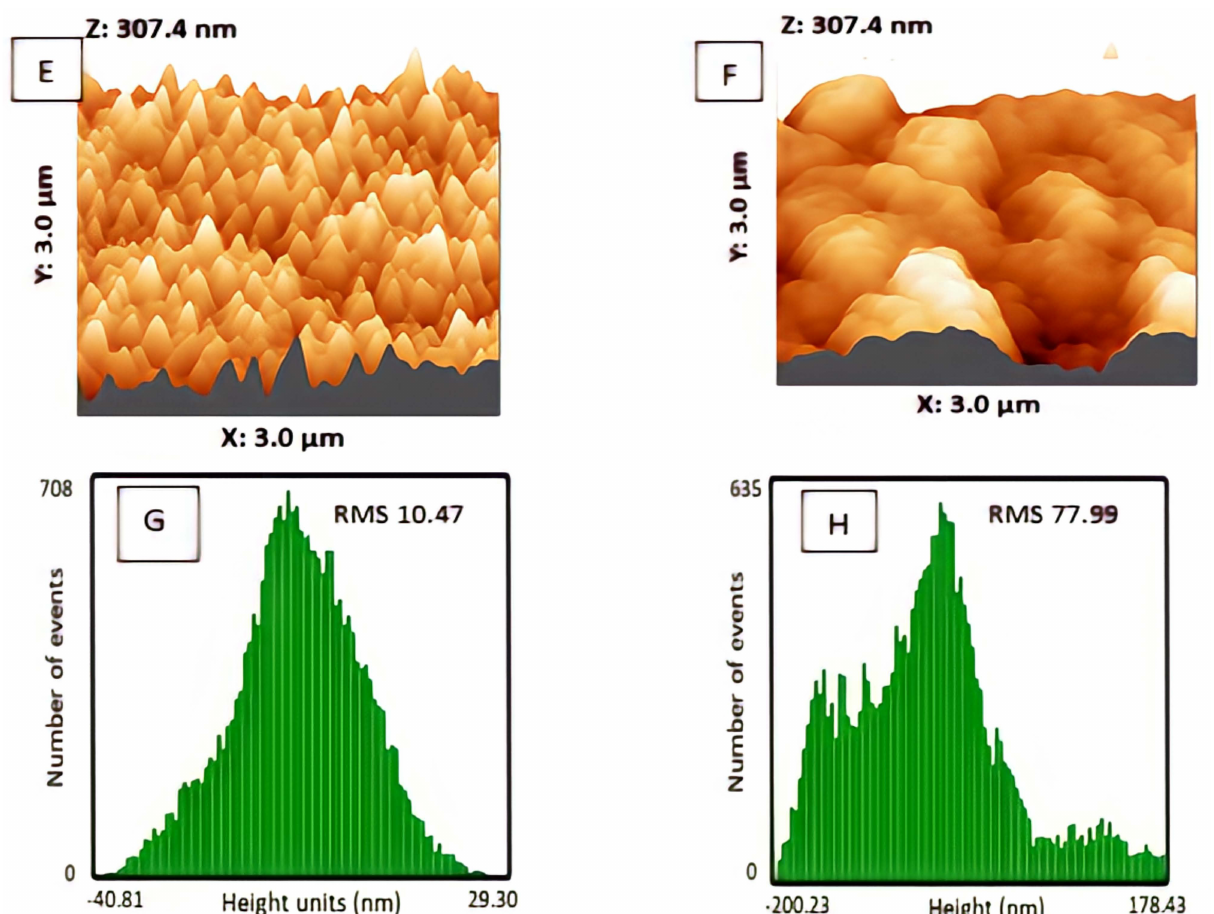
Figure 1. Morphology of membrane surfaces as revealed by SEM and AFM. ( A , B ) show the SEM surface images of PT and PTUC. ( C , D ) show 2D AFM images of the surface of PT and PTUC. ( E , F ) show 3D AFM images of the surface of PT and PTUC. ( G , H ) show AFM surface roughness of the surface of PT and